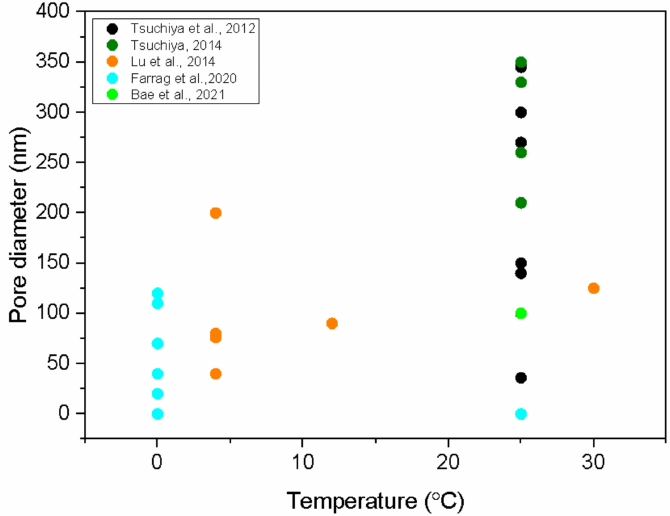
Figure 4. The diameter of nanopores versus the electrolyte temperature. Authors and year of publica- tion of the studies stated in the legend are also cited in the references at the end of the